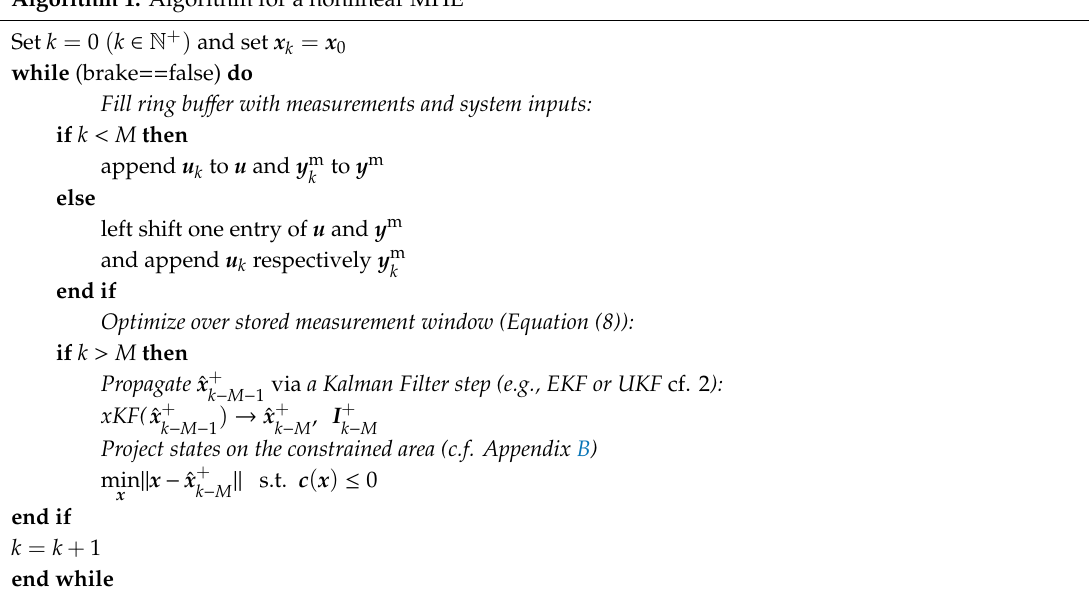
Algorithm 1. Algorithm for a nonlinear MHE